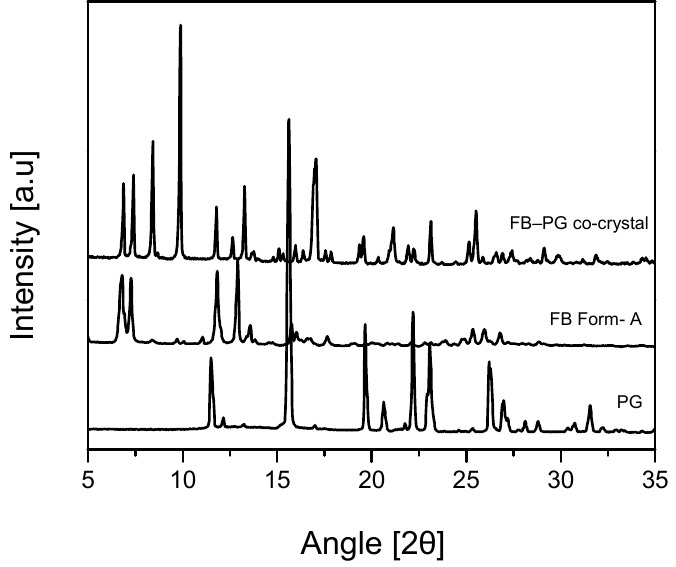
Figure 4. 2 θ powder X-ray diffraction (PXRD) patterns of FB-PG cocrystal, FB form-A, and PG.